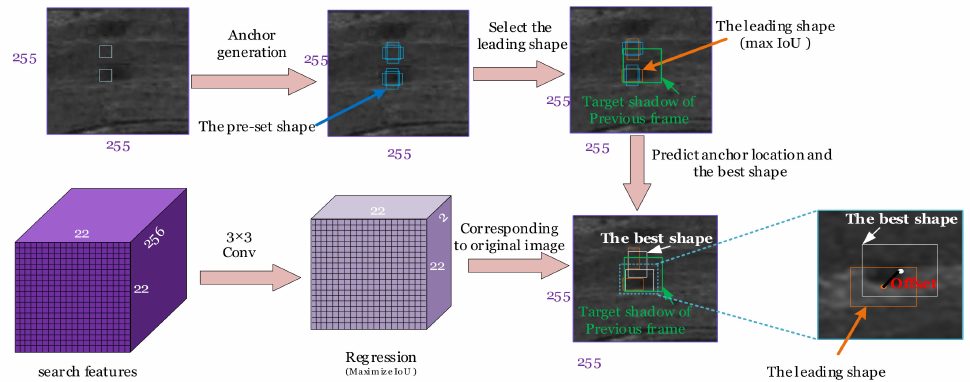
Figure 8. Predict anchor